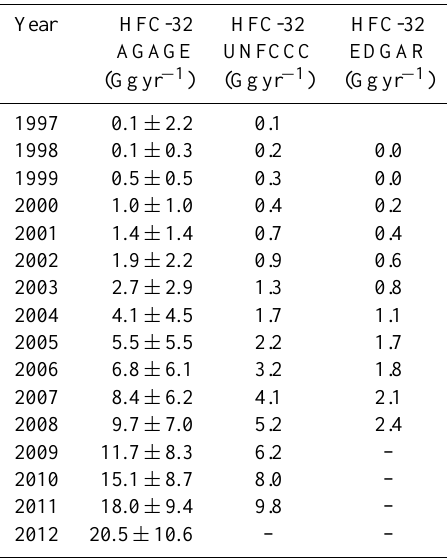
Table 3. Estimates of global emissions of HFC-32 (Ggyr − 1 ) based on AGAGE in situ measurements and archived air samples (the NH flasks were collected primarily at Trinidad Head and the SH flasks at Cape Grim) using the AGAGE 2-D 12-box model. Estimates of total emissions prior to January 2004 are based only on archived air samples. Also shown are global emission estimates derived from UNFCCC National Inventory Reports (2012 submission) and from the EDGAR (v4.2)